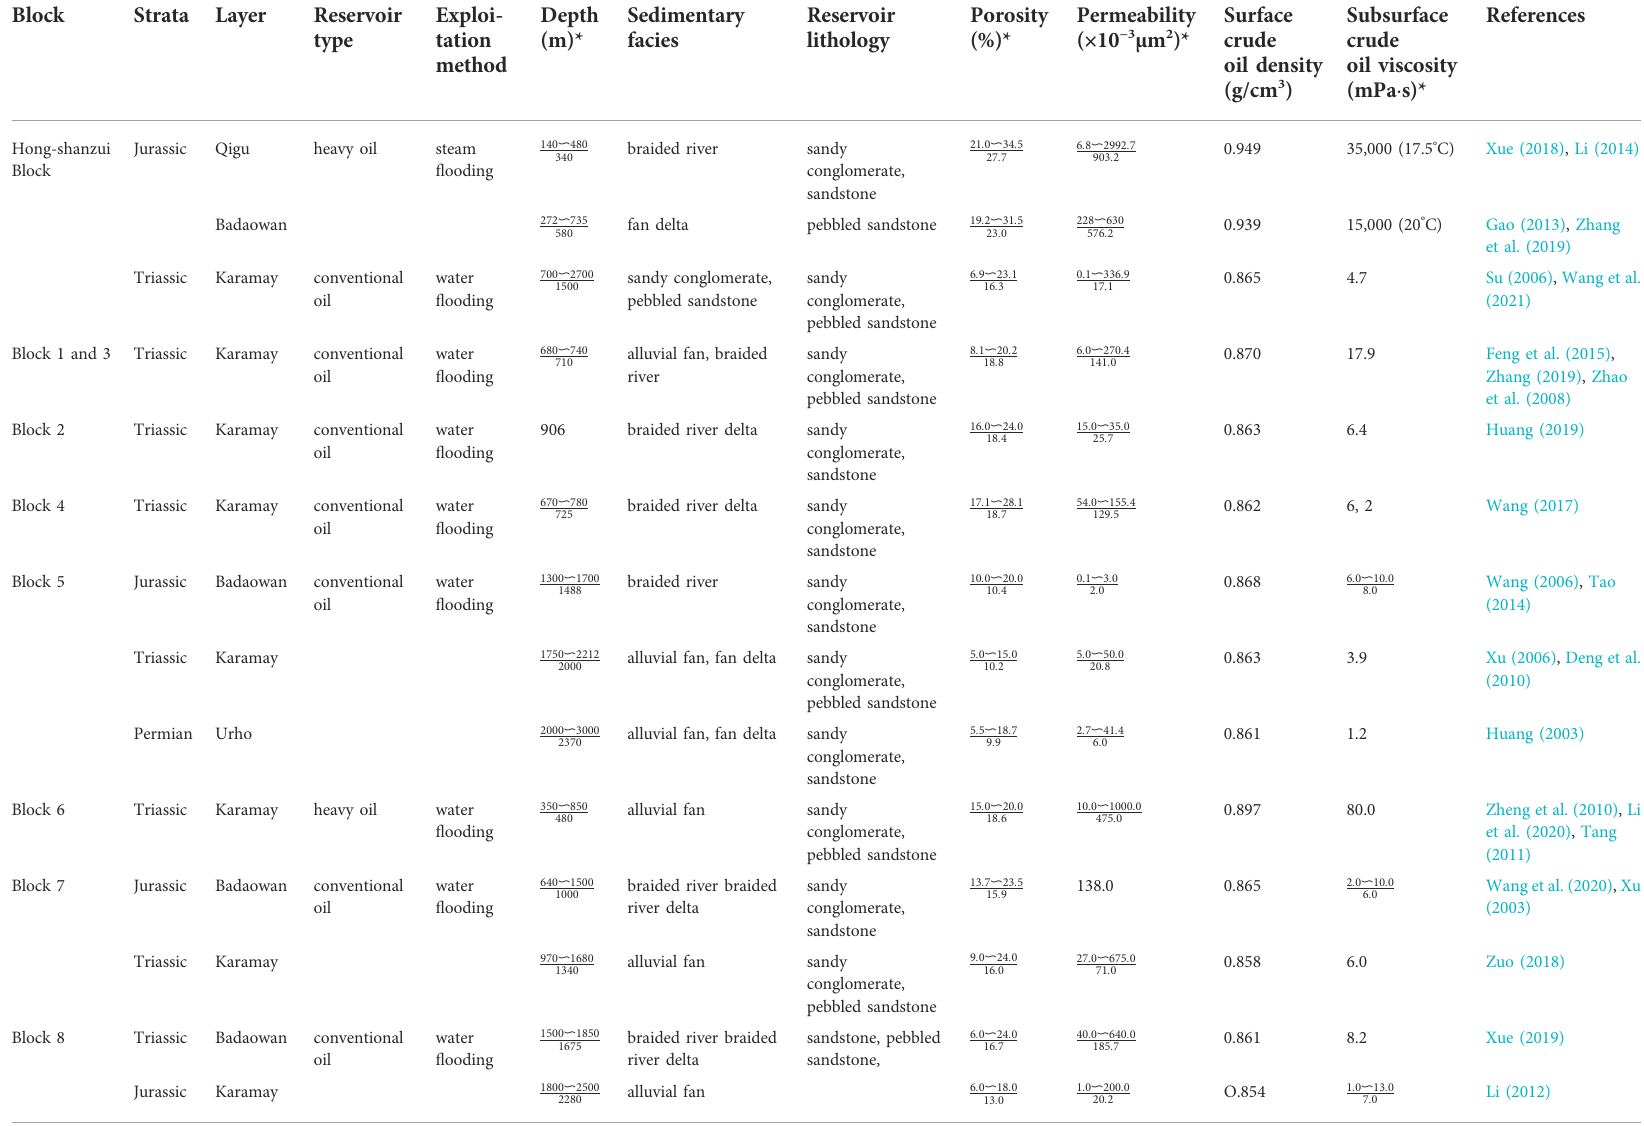
TABLE 2 Geological data and oil fi eld data of different